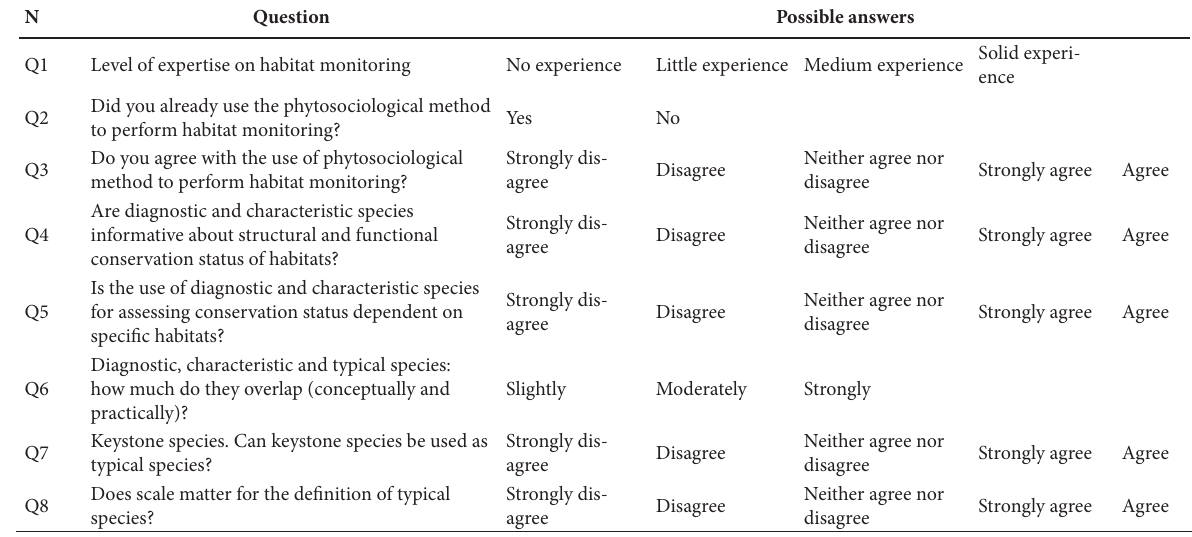
Table 1. Questions and possible answers provided to the surveyees. The Q3-Q8 answers followed the “Likert scale” (Likert